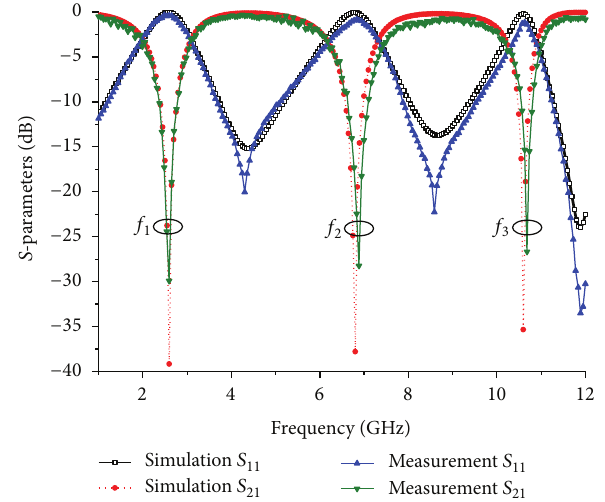
Figure 9: Measurement and simulation result of the proposed symmetric